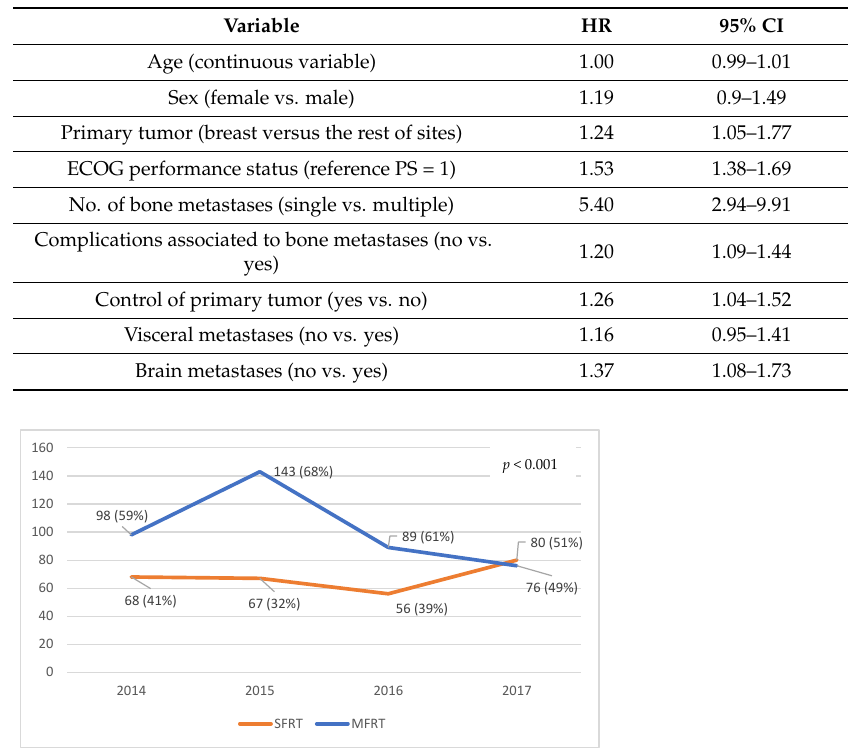
Table 3. Multivariate analysis of 3-year overall survival.